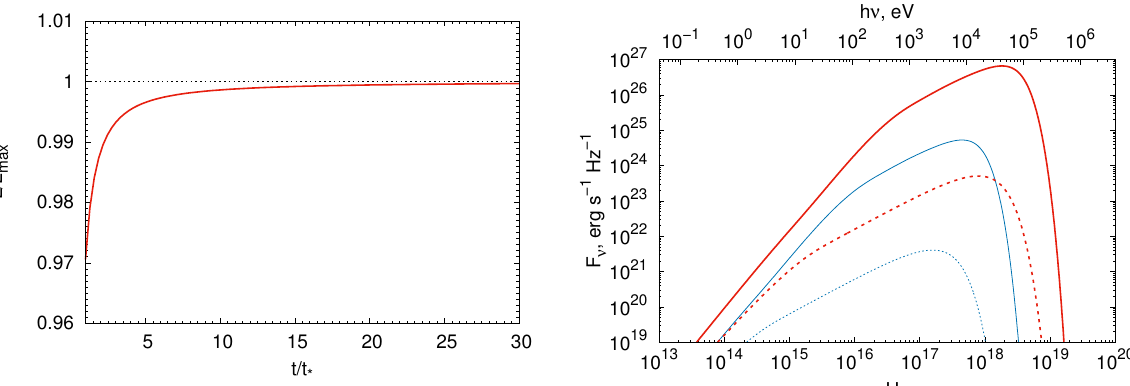
Figure 8. Self-similar dependence of bolometric luminosity on time L ( t ) L ( t ) L ( t ) (left) for model with parameter μ = 100 μ = 100 μ = 100 . Spectra of electromagnetic radiation F ν F ν F ν obtained from self-similar solution for radiative (thin lines) and convective (thick lines) disks. Solid lines describe the spectra of perturbed disks, and dotted lines describe the corresponding spectra of undisturbed